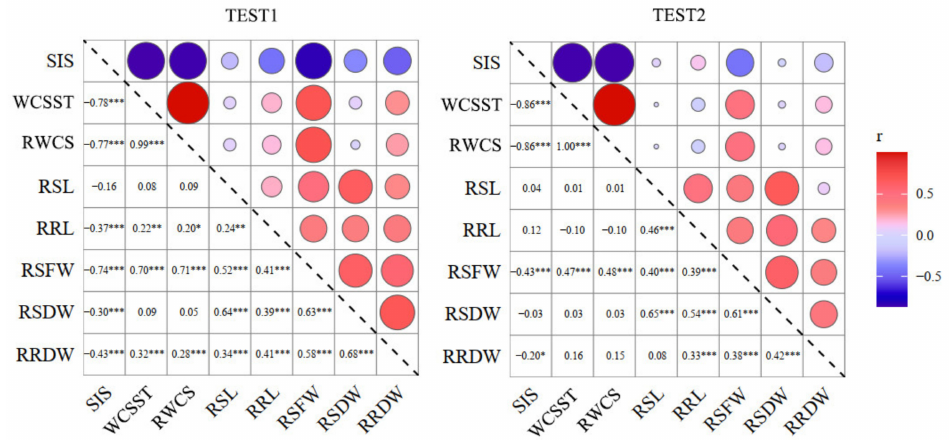
Figure 2. Correlation analysis of salt-tolerant traits of BILs. Notes: SIS, salt injury score; WCSST, water content of seedling under salt treatment; RWCS, relative water content of seedling; RSL, relative shoot length; RRL, relative root length; RSFW, relative shoot fresh weight; RSDW, relative shoot dry weight; RRDW, relative root dry weight. *, ** and *** means significance at the 0.05, 0.01 and 0.001 level, respectively (2-tailed); r,